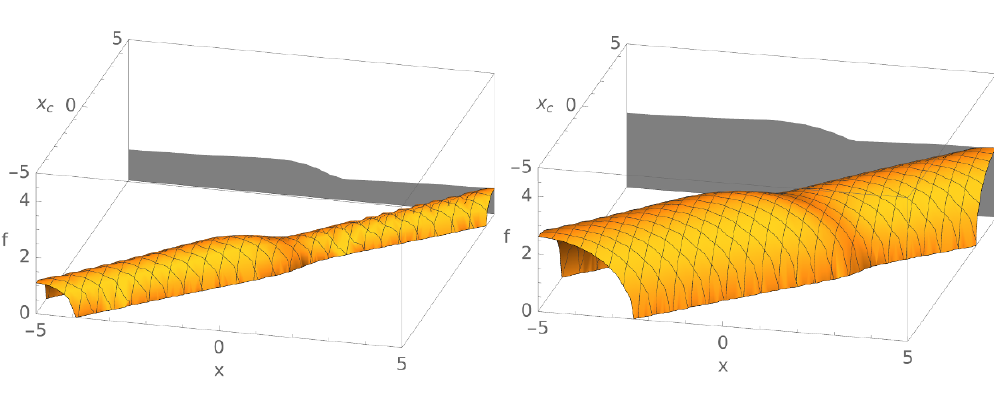
Figure 8 . Fictitious three-dimensional bodies. When viewed along the x c -axis, the silhouette of these bodies (shown in gray) corresponds to the functions z t